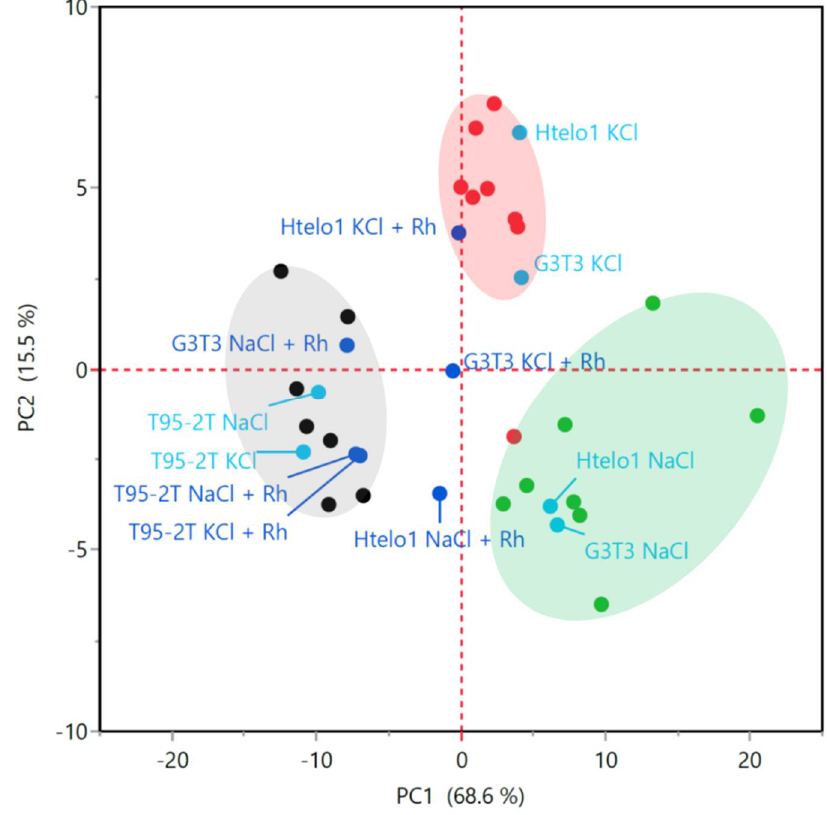
Figure 6. PCA plot of the first and second principal components. In parentheses is the fraction of total variance explained. The blue solid circles represent G3T3 , Htelo1 , and T95-2T with and without Rhau25 (Rh) in Na + and K + respectively (total of 12 samples). The three clusters represent the parallel (grey), antiparallel (green) and hybrid (red) topologies defined by the reference pdb data (black solid circles for grey cluster, green solid circles for green cluster and red solid circles for red cluster [35]). The analysis was carried out using the most distinctive interval of wavelengths (220–310 nm) of the CD spectra.